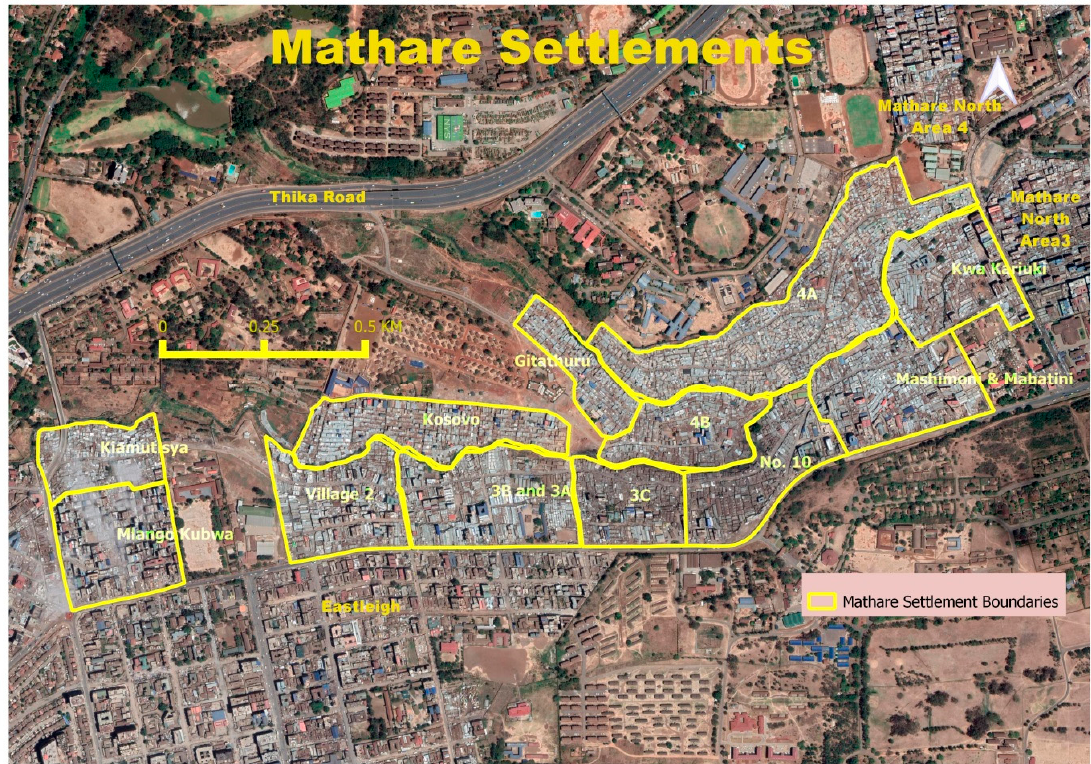
Land 2020 , 9 , x FOR PEER REVIEW Figure 2. Mathare informal settlement in Nairobi (Source: authors). Figure 2. Mathare informal settlement in Nairobi (Source: authors).